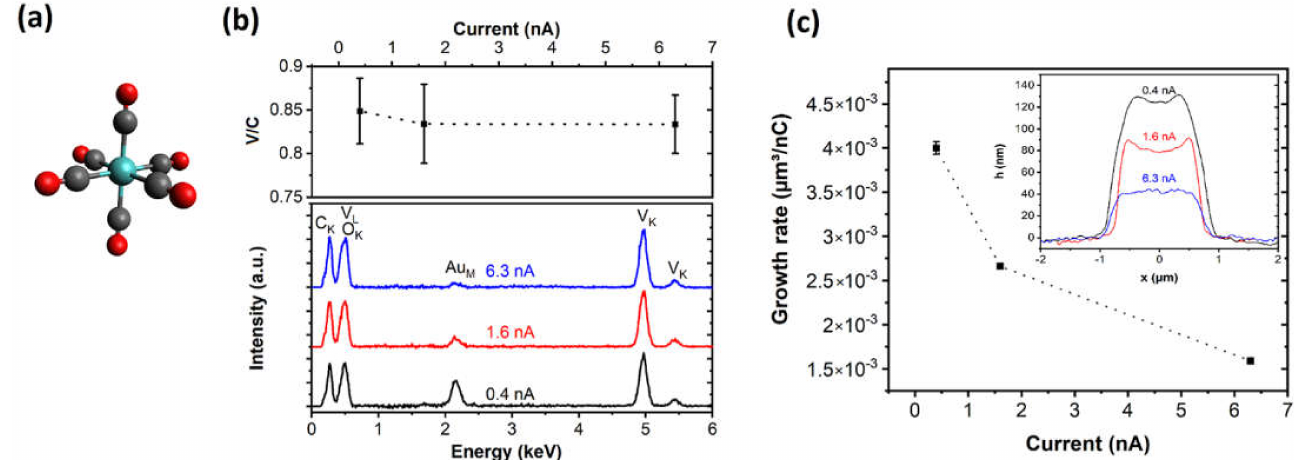
Figure 1. ( a ) Schematic illustration of the monomeric V(CO) 6 precursor used in this study. ( b ) The V/C ratio of the deposits is determined by EDX, and the variation is shown in response to changes in the beam current used at a constant acceleration voltage of 5 kV, including the corresponding EDX data. Further FEBID parameters include a deposition area of 1.4 µ m × 1.4 µ m a 20 nm pitch in the x- and y-direction, and a dwell time of 1 µ s. The substrates for the EDX studies are 250 nm Au layers with Cr (8 nm) adhesion layer on sapphire (0001) single crystals. ( c ) The inset shows height profiles of V-based FEBID material with a nominal 1.4 µ m × 1.4 µ m area deposited at a 5 kV beam voltage for different beam currents (as indicated) but identical doses of 40 nC · µ m − 2 . Further deposition parameters include: a pitch of 20 nm in the x- and y-direction and a dwell time of 1 µ s. The volume growth rate per dose is determined using the deposit volumes and is plotted in relation to the beam current used for